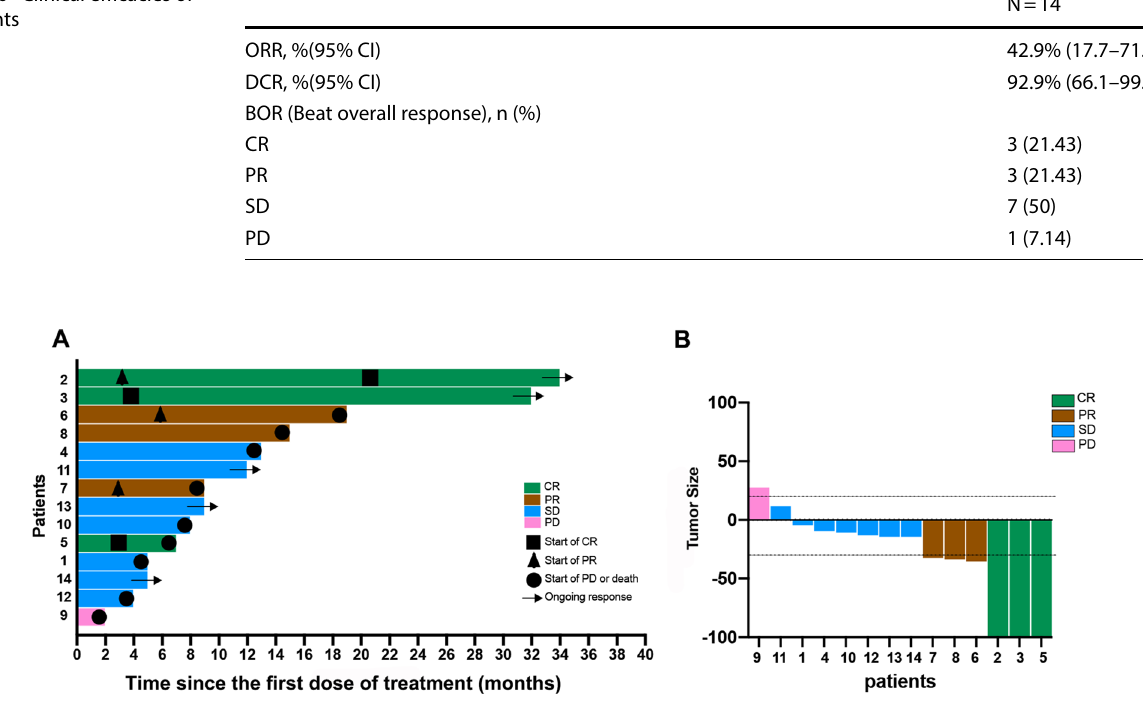
Fig. 2 Characteristics of objective response in patients with MiniPDX drug sensitivity testing protocol. A Duration of response (N = 14). B The maximum percentage reduction from baseline in target lesions (N = 14)